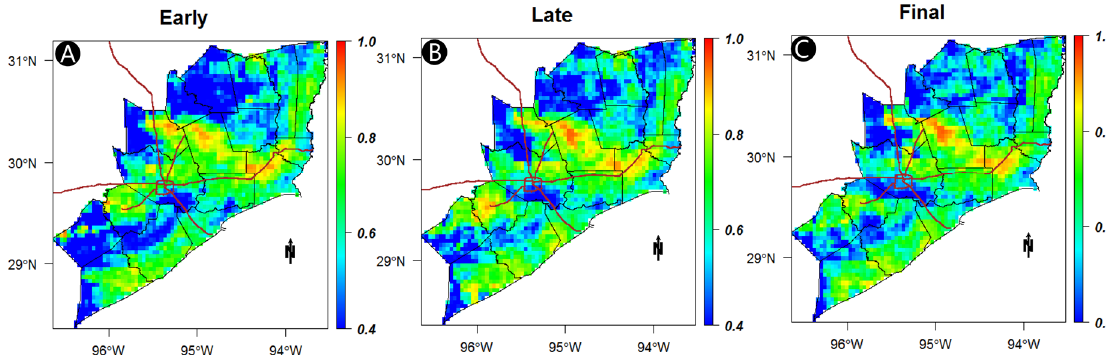
Figure 5. Spatial distributions of the correlation coefficient (CC) between Stage-IV radar data and ( A ) IMERG Early-, ( B ) Late-, and ( C ) Final-run products over 17 Counties in Texas ( n = 192; hourly from 14–21 September 2019).